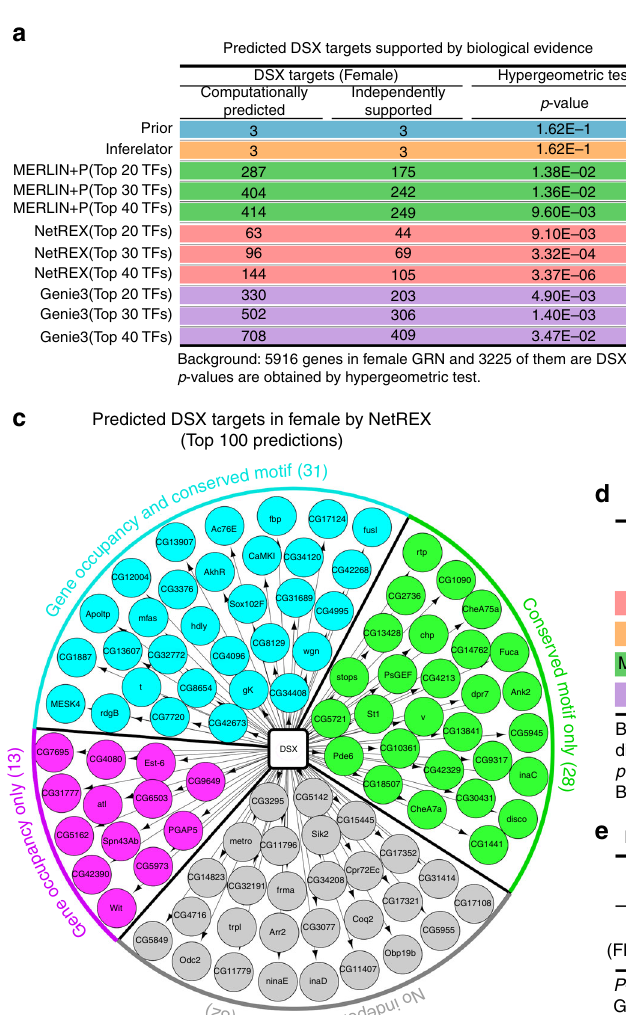
Fig. 4 Validation of predicted DXS targets (predicted without genes highly expressed in ovary). a Enrichment of experimentally supported DSX targets recovered by different methods for female GRN. Enrichment for male GRN without testis is shown in Supplementary Table 11. b Precision-recall curves for predicting DSX targets for compared methods. The DSX targets predicted by each method are ranked by assigned weights. A high area under the curve corresponds to high precision (low false positive rate) and high recall (low false negative rate). As the ground truth we use DSX targets reported in ref. 30 based on ChiP-Seq occupancy and conserved motif scores. c Top 100 targets predicted by NetREX in the female GRN. d Enrichment of predicted DSX targets in genes with sex-biased expression for the female GRN. Different methods might predict different number of regulators for each gene. To fairly compare those GRNs we take for each method the k -best ( k = 20) predictions for each gene. Comparison of other k s is shown in Supplementary Figure